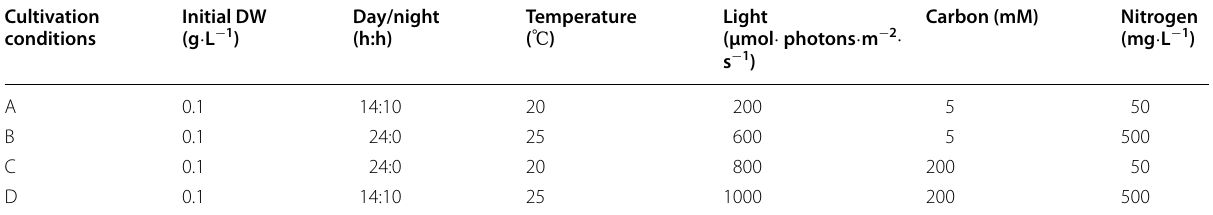
Table 3 List of arbitrary cultivation condition parameter value Cultivation